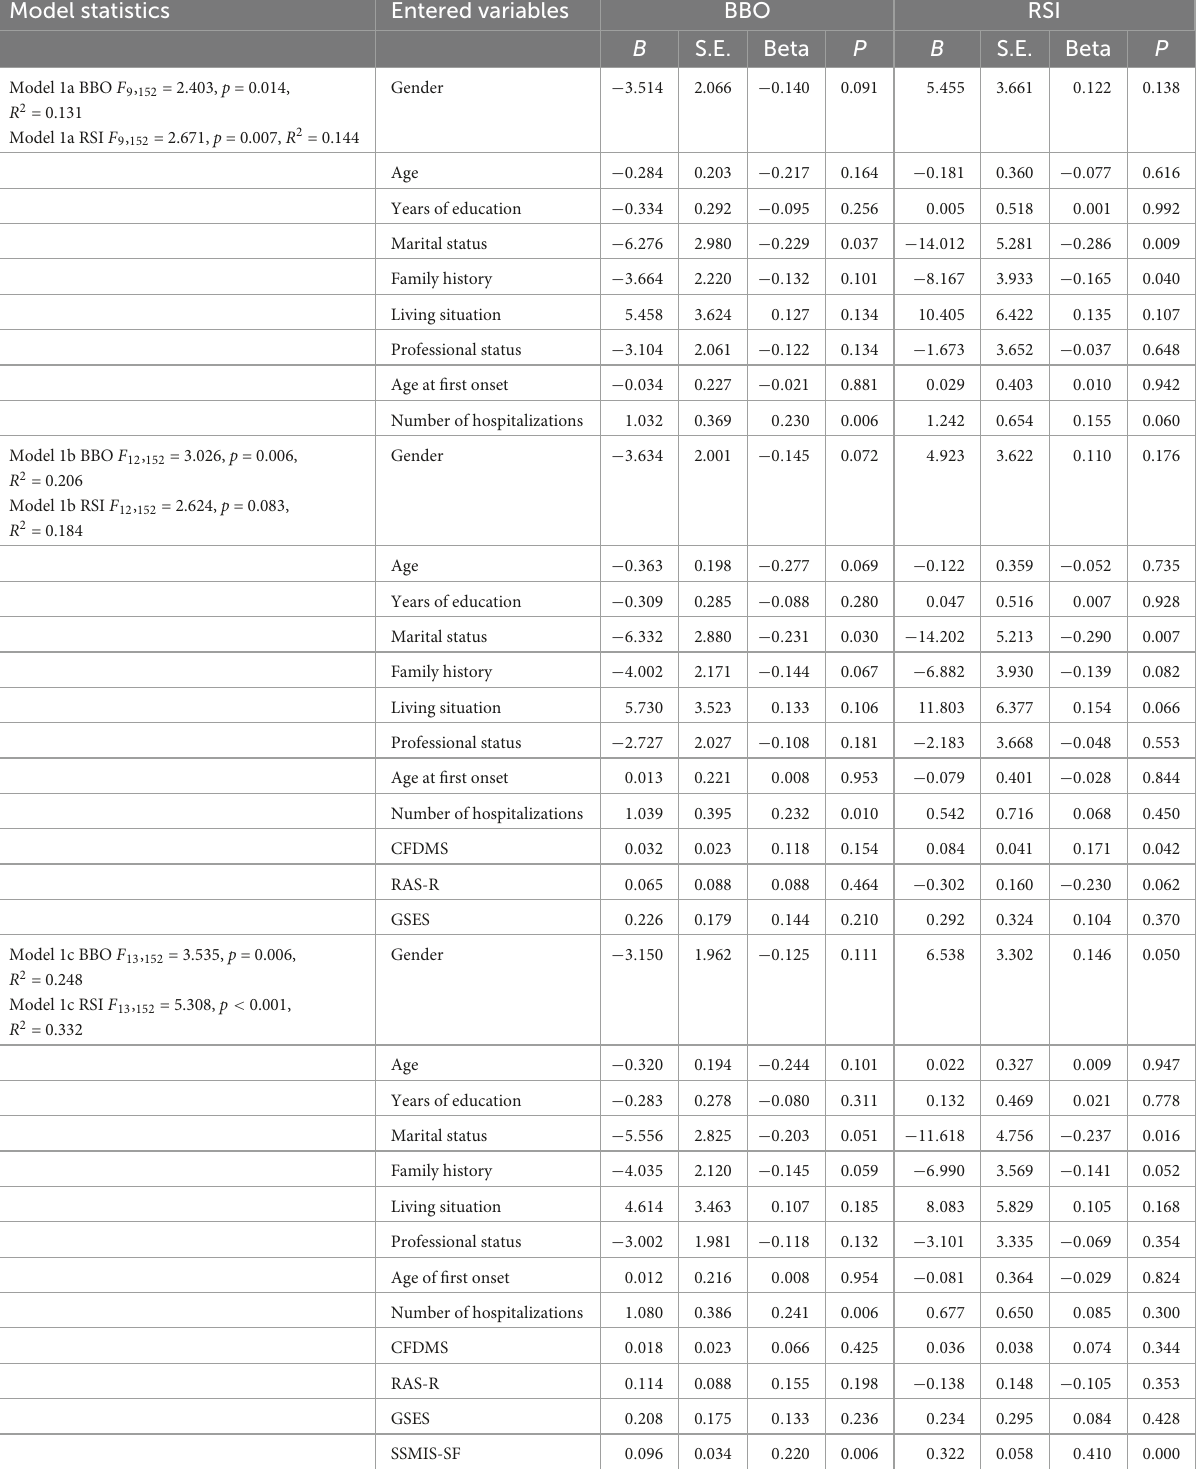
TABLE 2 Predictors of BBO and RSI for patients. Model